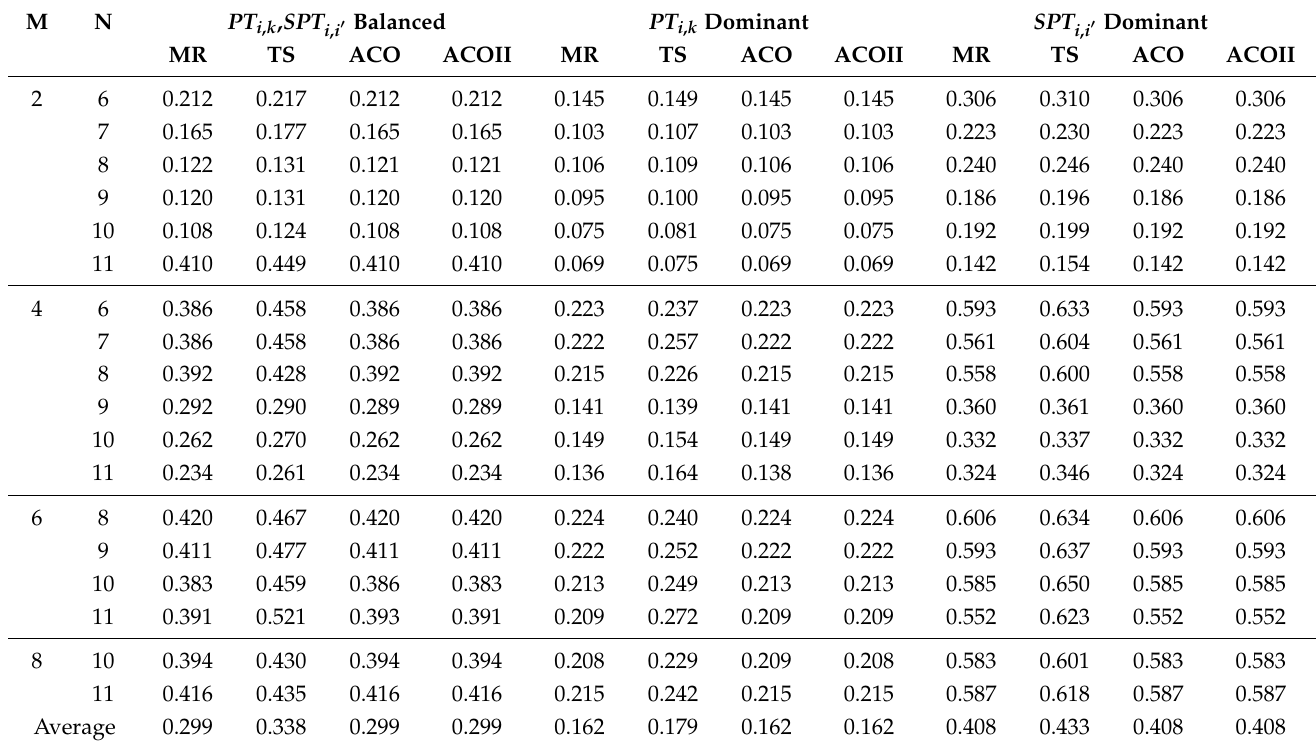
Table 2. Average deviation of the existing algorithm from the ILCA.